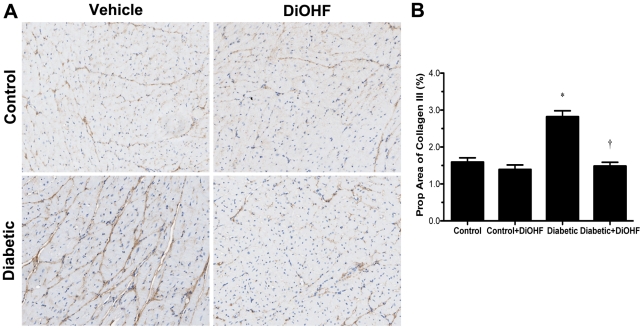
Immunohistochemistry staining for collagen type III.(A) Representative images. Brown region represents positive immunostaining for collagen type III which was substantially increased in diabetic rats and reduced by DiOHF treatment. The amount of collagen type III was found to be similar in control and control-treated rats. Collagen type III interstitial accumulation as assessed by proportional area on sections showing positive immunostaining in control and diabetic rats treated with or without DiOHF (B). Data expressed as mean ± SE. Data expressed as mean ± SE. *P<0.05 vs control (non-diabetic) rats; †P<0.05 vs diabetic rats. Original magnification ×200.